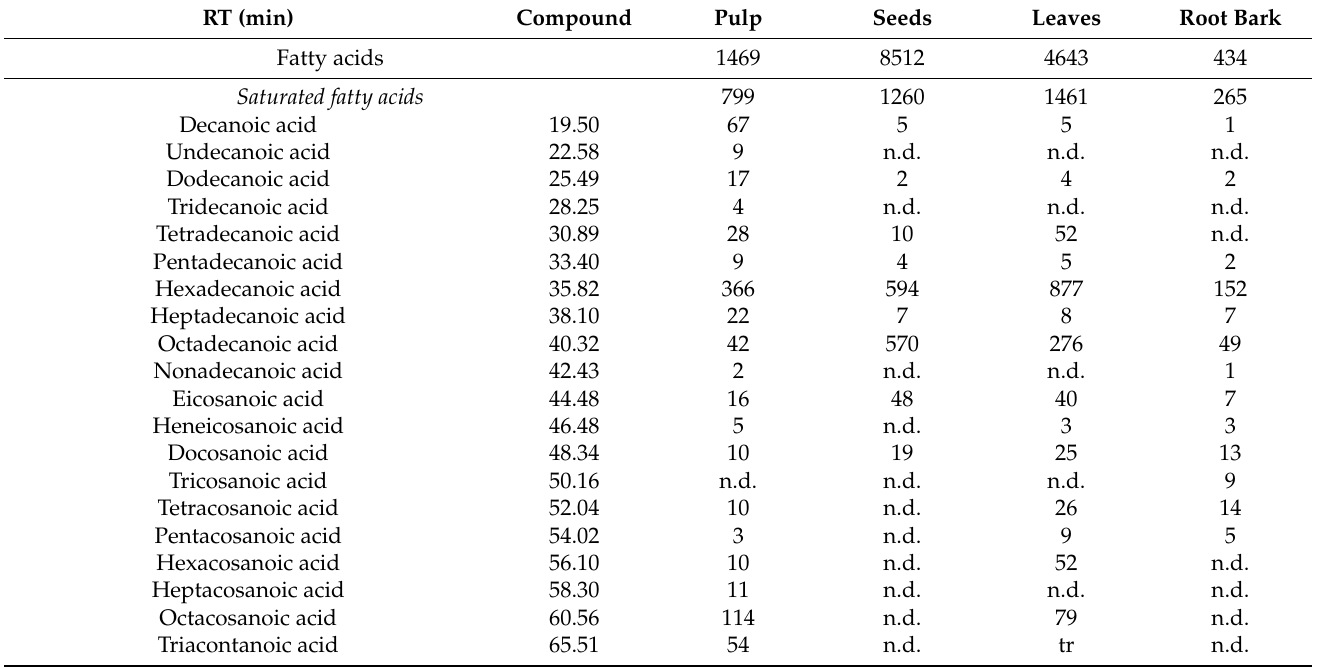
Table 1. Quantitative analysis (mg kg − 1 of dry weight) of lipophilic extracts derived from four morphological parts of Zizyphus lotus